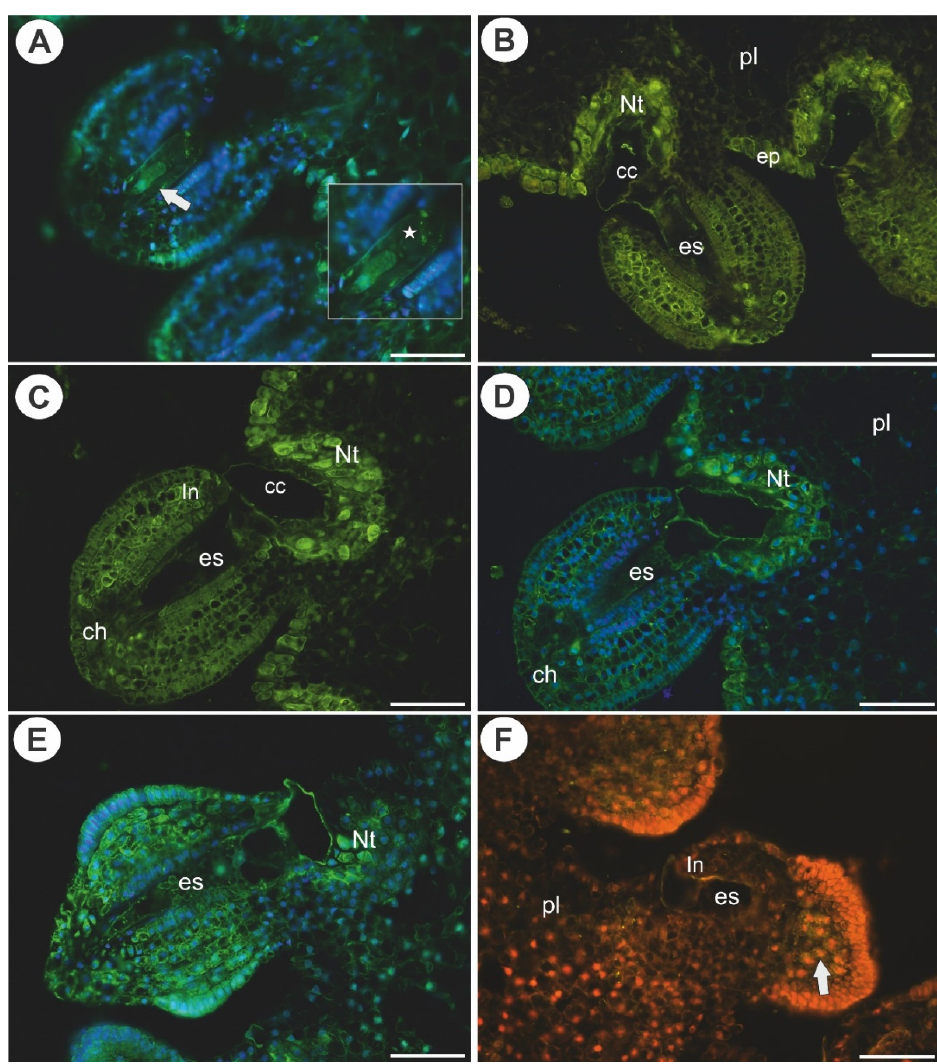
Figure 4. Arabinogalactan proteins (labeled with JIM14 and with LM2) detected in Utricularia nelumbifolia and Utricularia humboldtii before pollination. ( A ) Arabinogalactan protein (labeled with JIM14, green fluorescence) detected in the ovule of U. nelumbifolia that did not contain a mature female gametophyte (arrow). Note the occurrence of AGPs in remaining nucellus epidermis (star, framed part). ( B – D ) Arabinogalactan protein (labeled with LM2, green fluorescence) detected in U. nelumbifolia ; note the strong positive signal in the nutritive tissue (Nt) and epidermis of placenta (ep); embryo sac (es), chalaza (ch), hypertrophied part of central cell (cc), integument (In). ( E , F ) Arabinogalactan protein (labeled with LM2, green fluorescence) detected in U. humboldtii: embryo sac (es), pl (placenta), nutritive tissue (Nt), positive signal in ovule tissue (arrow); yellowish signal is autofluorescence. All bars 50 µm.